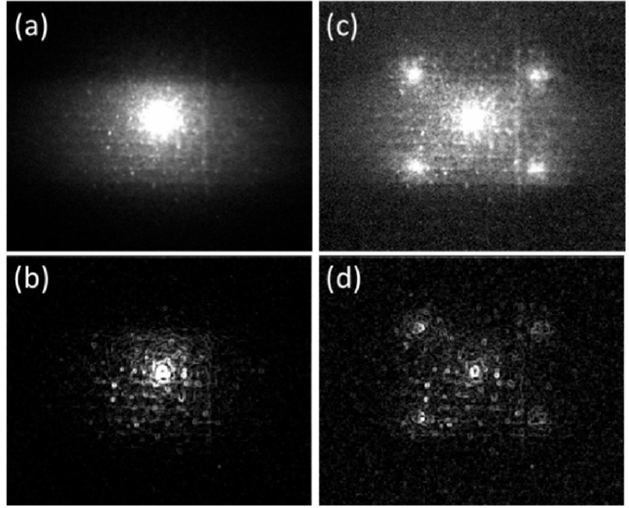
Figure 5. ( a , c ) are amplitude image of single-spot and multi-spot LLT measurement with f = 0.1 Hz. ( b , d ) are post-processed ( a , c ) by Sobel kernel, respectively.